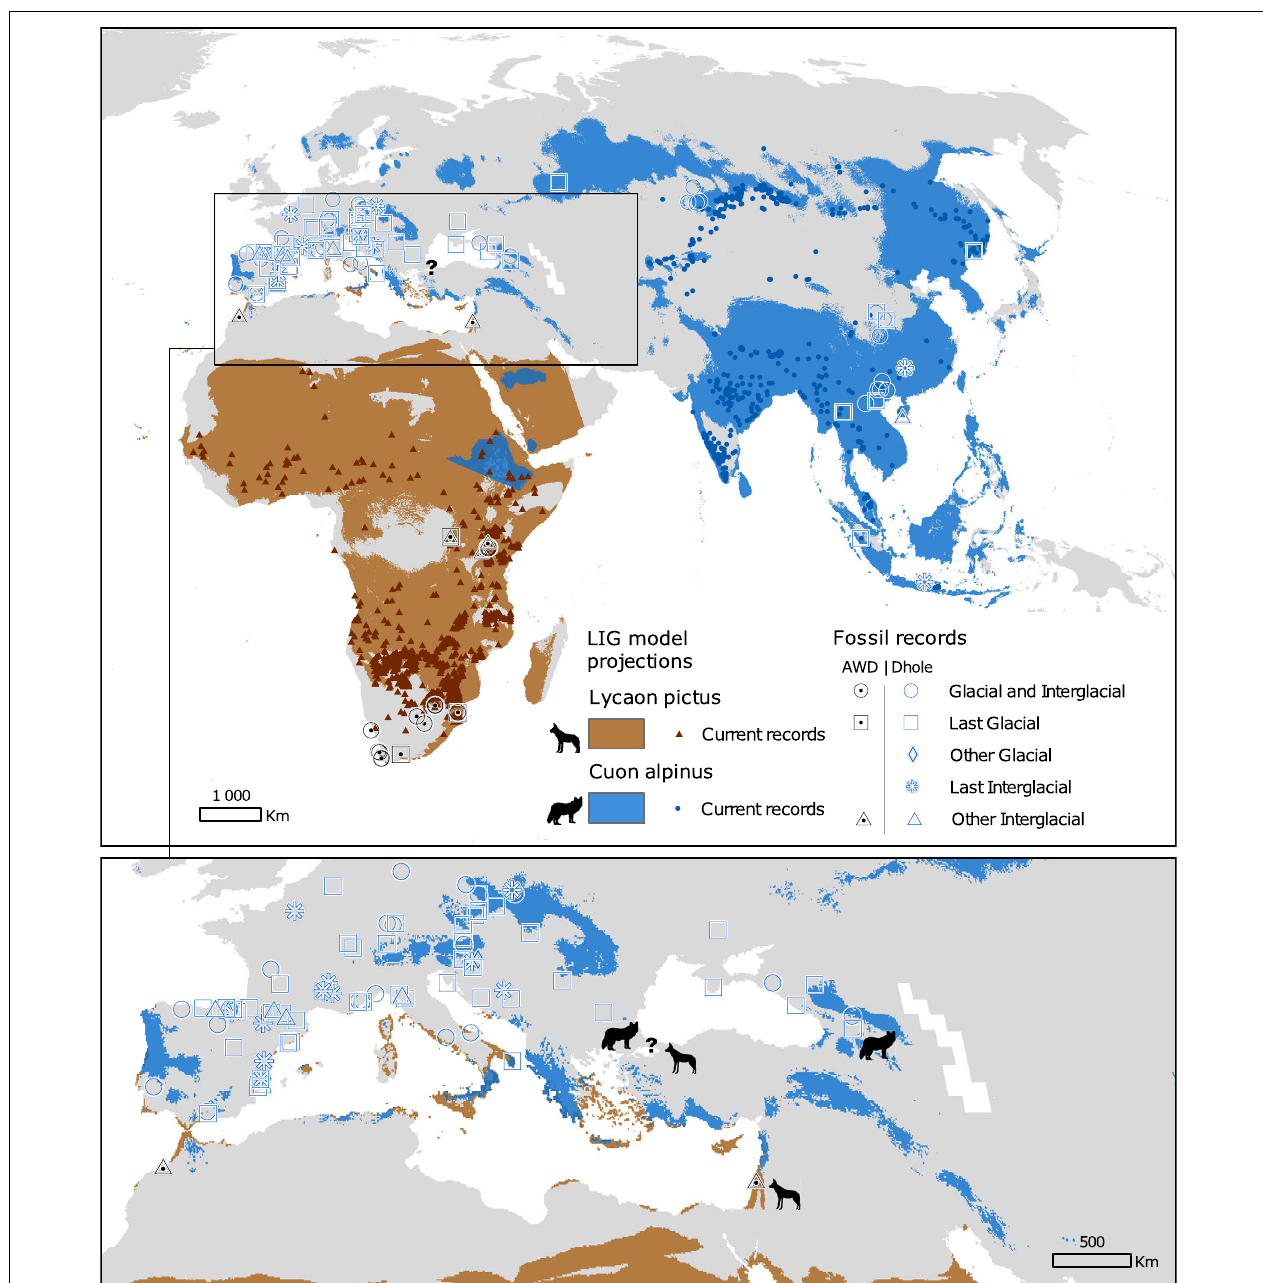
FIGURE 1 | Predicted distributions for the Last Interglacial period (LIG; 130 kya) obtained from SDM model projections for the dhole ( Cuon alpinus; blue color) and the African wild dog (AWD, Lycaon pictus ; brown color), including current and fossil records of both species (above). Inset of the model projection of both species, highlighting the Mediterranean region and the possible contact in the Levant region (below). The question mark (?) refers to a dubious fossil of the Yarinburgaz Cave in western Turkey, for which identification is unclear (see explanation in the